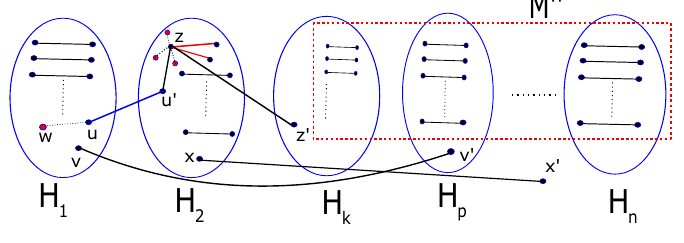
Figure 5: Case 2.2.2.1: | F V